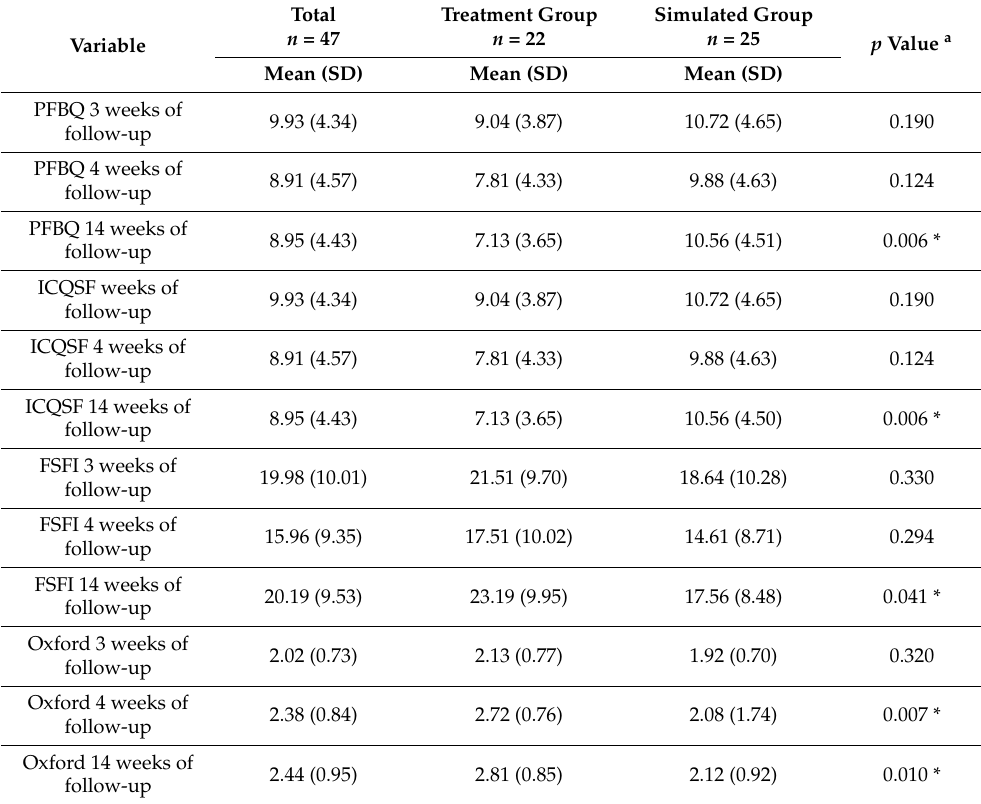
Table 2. Variation in the scores of the PFBQ, ICQSF, FSFI, and Oxford questionnaires at weeks 3, 4, and 14 of